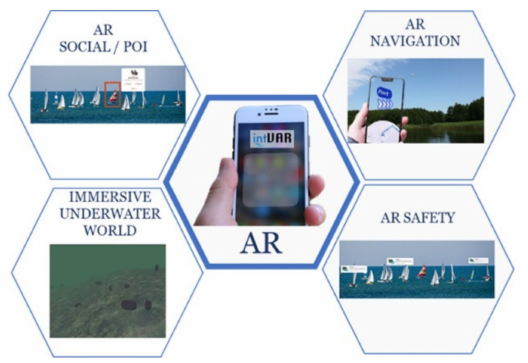
Figure 4. Types of AR functionality supported by the proposed